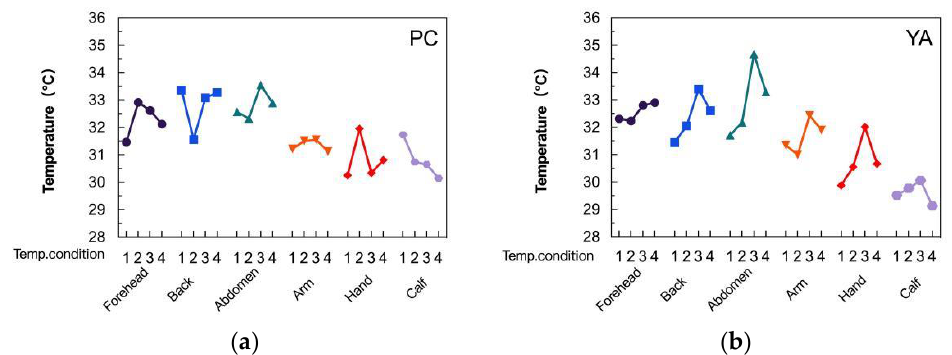
Figure 5. Local skin temperatures in two groups of participants: ( a ) Preschool children; ( b ) Young adults.